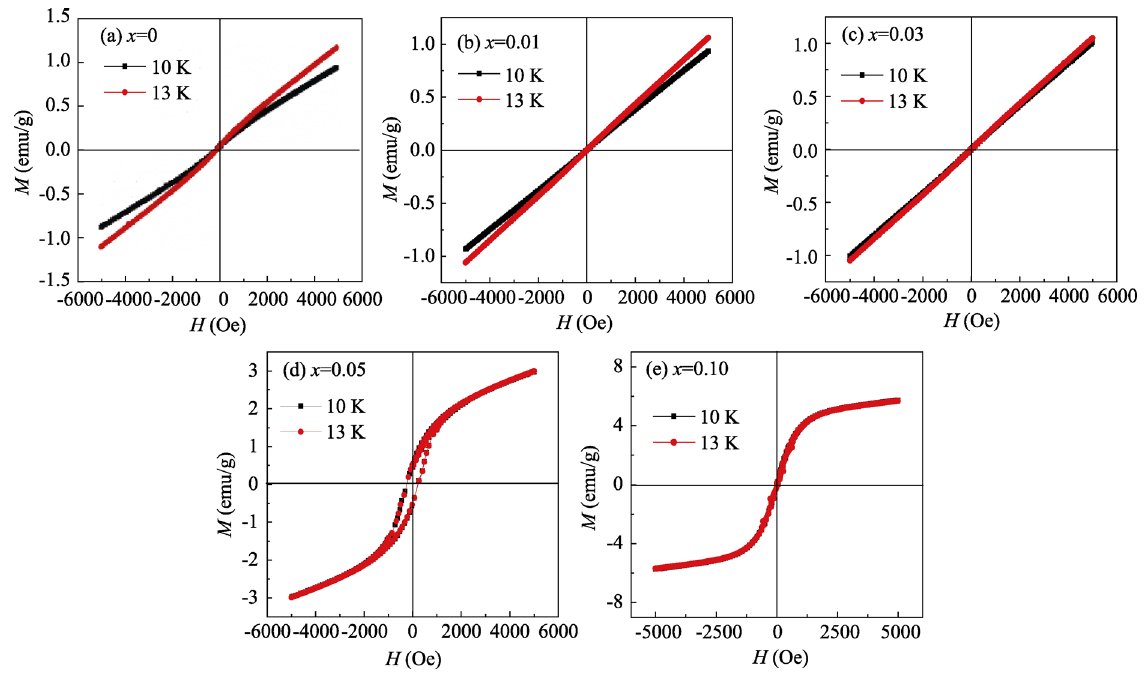
Fig. 11 M – H loops of the CuFe 1− x Mn x O 2